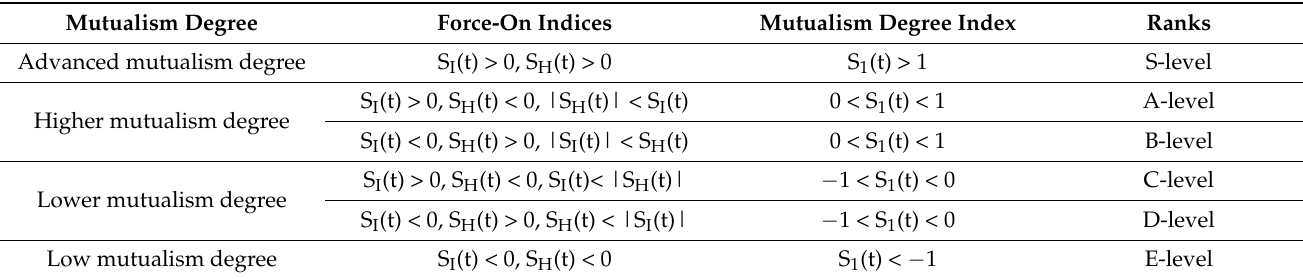
Table 1. HDI and industrial pollution effectiveness ranking basis.